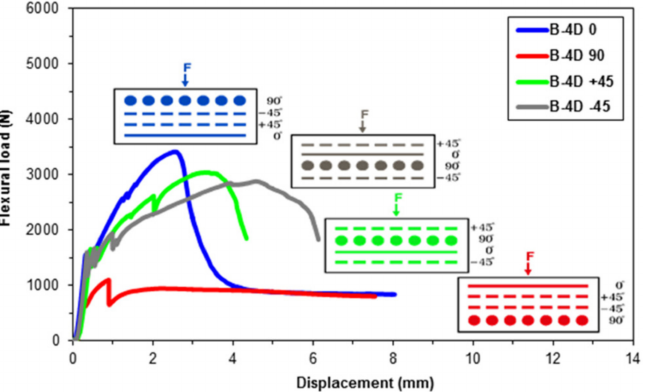
Figure 9. General characterization of the off-axis flexural load-displacement curves of B-4D con- crete